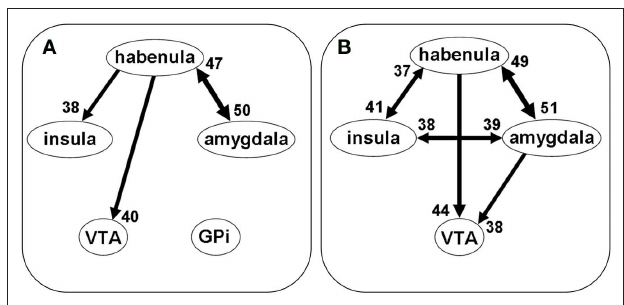
Figure 6 | granger causality analysis (gCA) indicated the directions of influence between the BOLD time series of regions of interest. (A) Shows the results of five ROIs: habenula, insula, amygdala, ventral tegmental area/ substantia nigra (VTA/SN), and internal globus pallidus (GPi). The GPi did not show Granger causality with any other brain regions. Thus, we removed the GPi in a second model (B) of multivariate GCA. The results at (B) show that the habenula, insula, and amygdala are bidirectionally connected, while the habenula and amygdala unilaterally project to the VTA/SN. GCA was performed and evaluated for each connection of each individual subject, at p < 0.05, corrected for FDR. Group results were obtained using a binomial test for each connection ( p < 0.05). The numbers next to the arrows indicate the number of subjects out of 59 who have that connection.